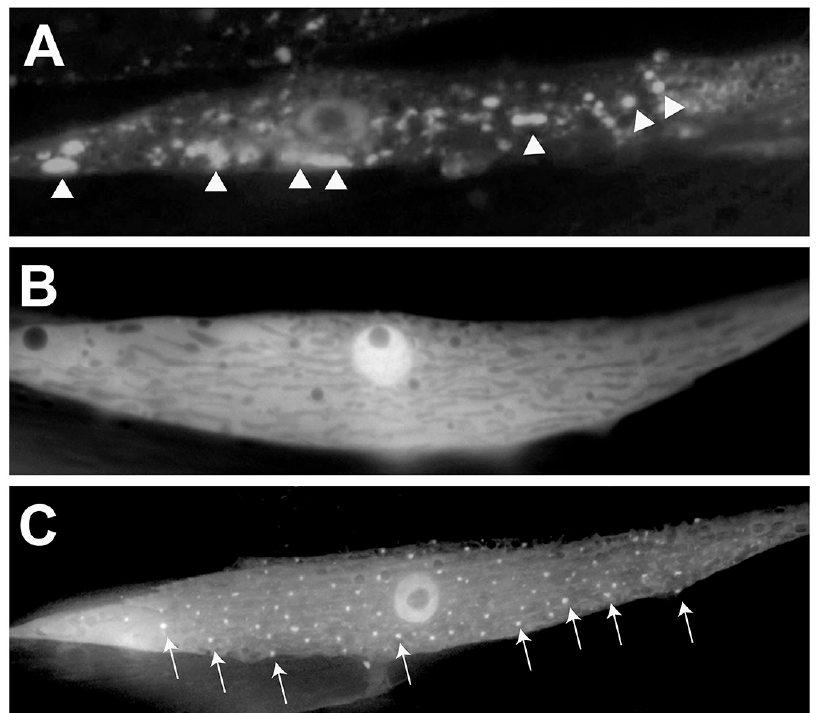
Figure 4. Use of C. elegans to model human α -syn misfolding. ( A ) A closeup image of a muscle cell in a transgenic worm expressing human, wild-type α -syn translationally fused to Green Fluorescent Protein (GFP) driven under the body wall muscle cell-specific unc-54 promoter. Arrowheads indicate areas of large accumulations of misfolded α -syn. ( B ) A closeup of a worm muscle cell co-expressing human, wild-type α -syn translationally fused to GFP and the chaperone protein, TOR-2, driven as distinct expression constructs by the body wall muscle cell-specific unc-54 promoter. TOR-2 serves to attenuate the amount of α -syn misfolding; the resulting GFP expression appears soluble and without puncta, indicating minimal misfolding/accumulation. ( C ) A closeup of a worm muscle cell expressing human, wild-type α -syn translationally fused to GFP in the presence of the chaperone protein TOR-2, both driven under the unc-54 promoter. In this panel, a gene has been knocked down via RNAi that enhances α -syn misfolding. Arrows indicate areas of visible α -syn::GFP.